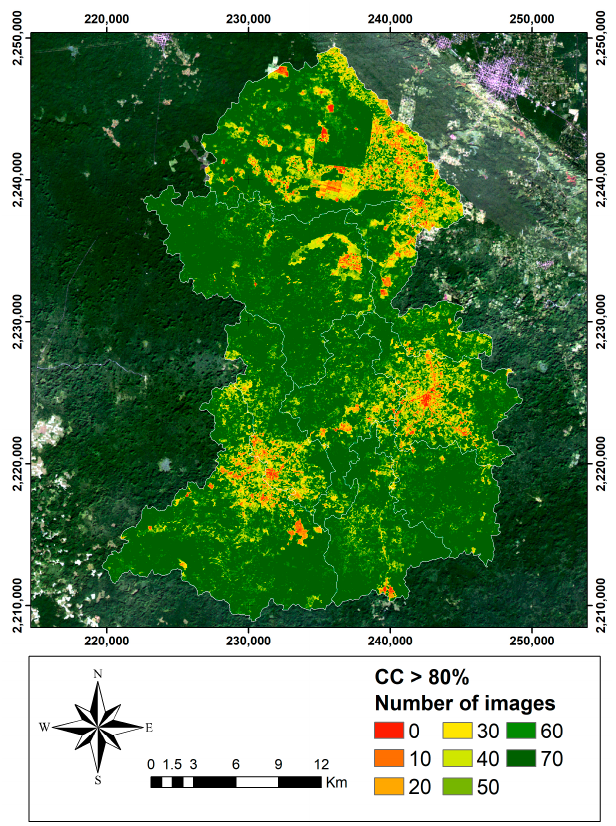
Figure 5. Observations where forest remains “stable”. Table 9. Reference values for the study area.